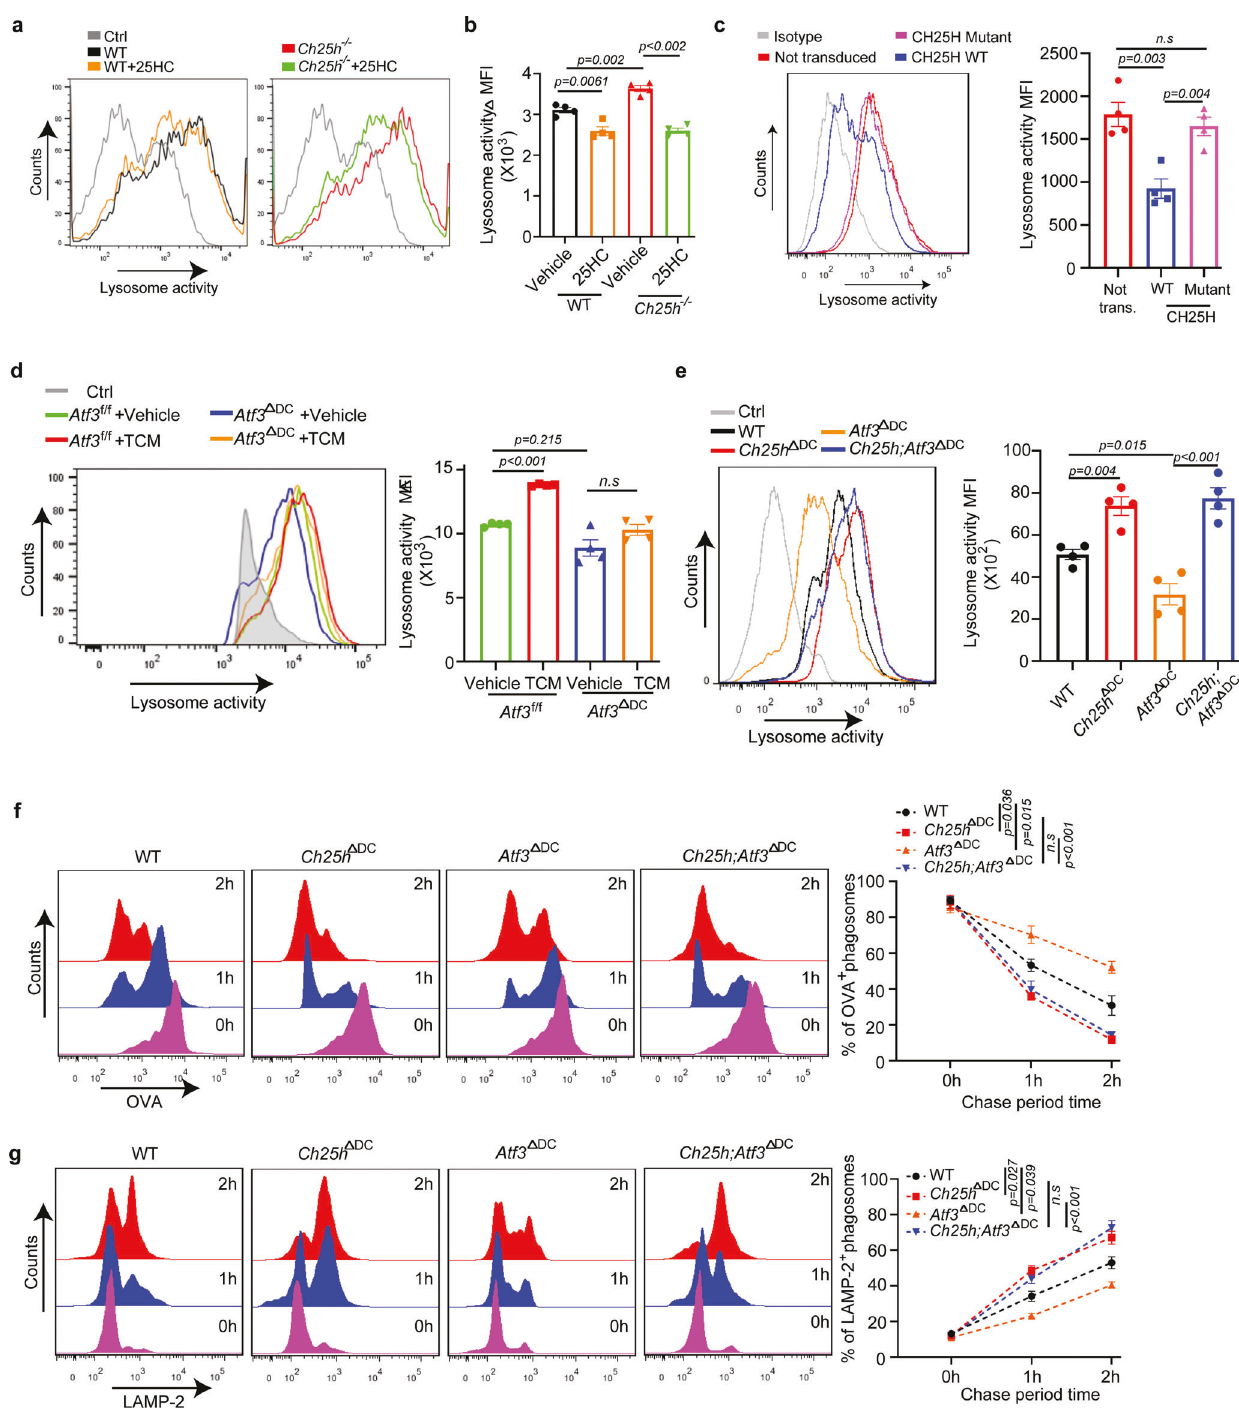
fl uorescence in indicated DCs pretreated with TCM from LLC cells (75%, v/v) for 24h. n =4 biologically independent samples. f Histograms show phagosomal degradationofOVA(left)anditsquanti fi cation(right)afterindicatedchaseperiods ( n =3 biologically independent samples). g Histograms show phagosomal acqui- sition of LAMP2 (left) and its quanti fi cation (right) after indicated chase periods ( n =3biologicallyindependentsamples).Datapresentedasmean±SEM.Statistical analysiswasperformed using 1-wayANOVAwith Tukey ’ s multiple-comparison test (B and D) test or 2-way ANOVA with multiple comparison (F and G) or 2-tailed Students ’ t -test(CandE).n.s.,notsigni fi cant.Sourcedataareprovided asaSource Data fi